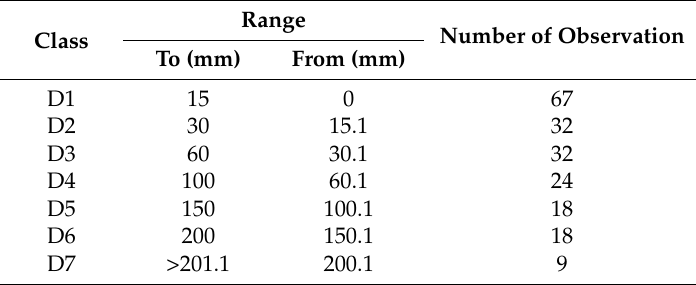
Table 3. Seven classes’ ranges and their number of observations.